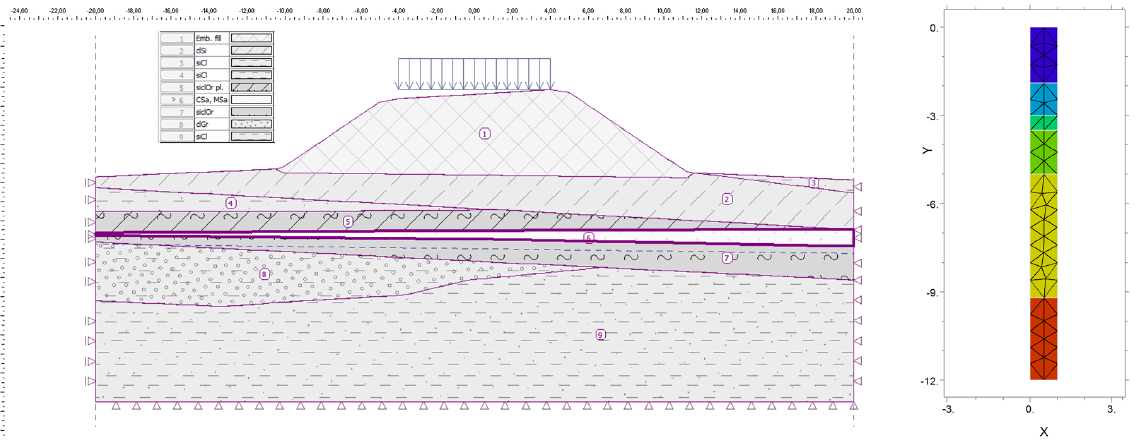
Figure 4: MES calculation cross-section for the consolidation process analyses. The possible drainage layer of organic soils was selected. Simplified calculation model is presented on the right